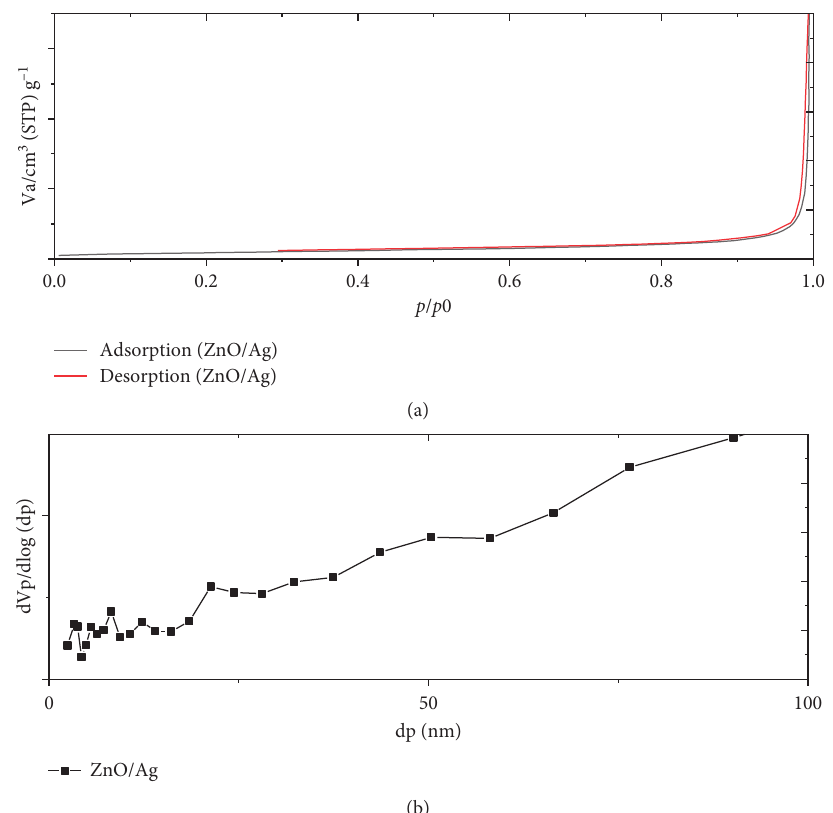
Figure 8: (a) Adsorption-desorption isotherms of nitrogen gas at 77K and associated (b) BJH plot showing the pore size distribution of